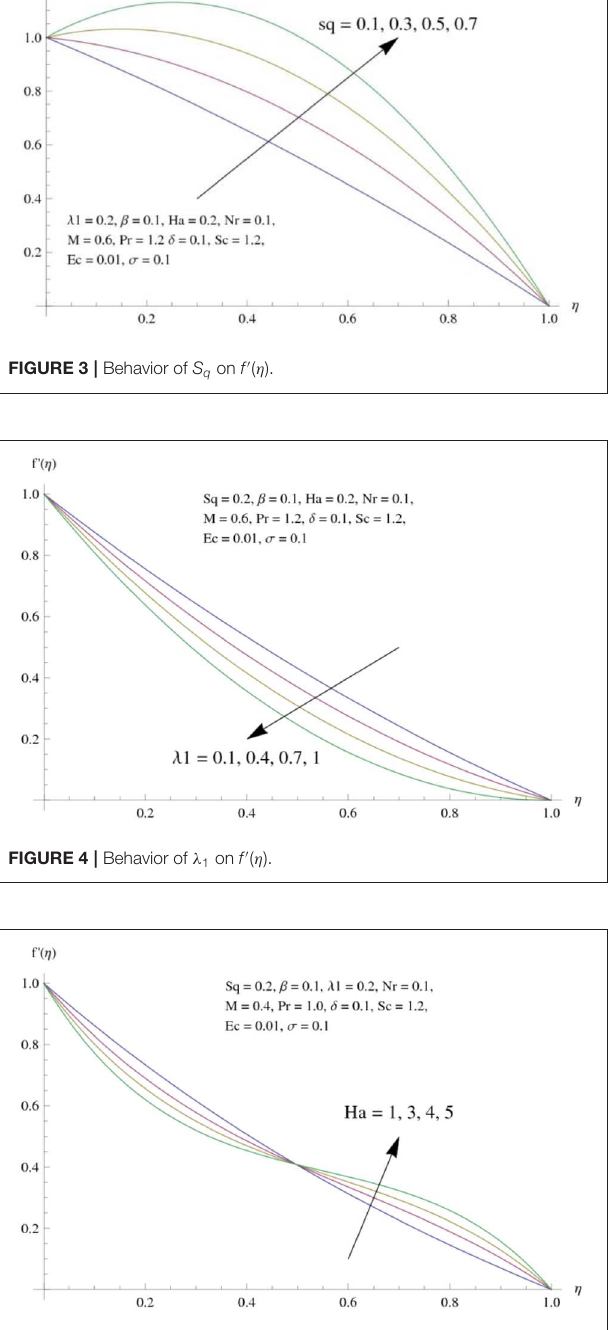
FIGURE 5 | Behavior of Ha on f ′ (η)